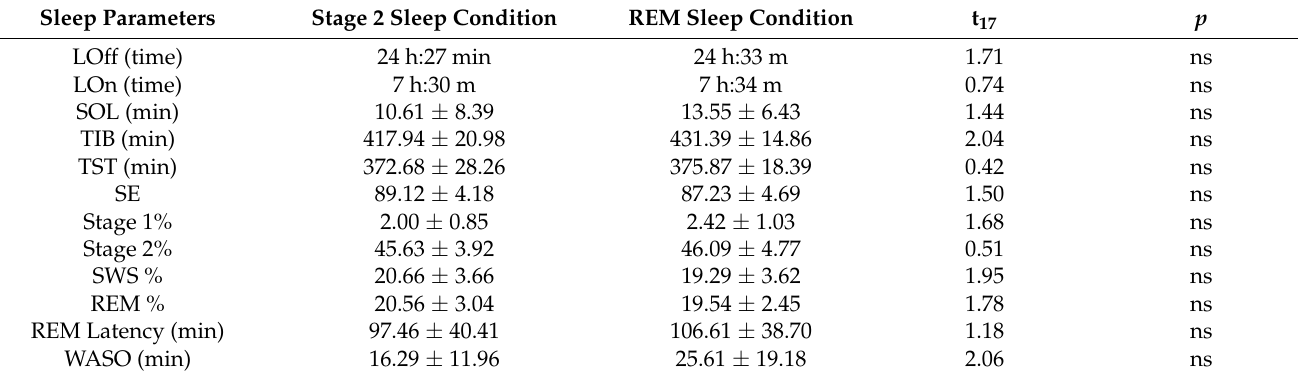
Table 1. Means and standard deviations of sleep parameters in experimental